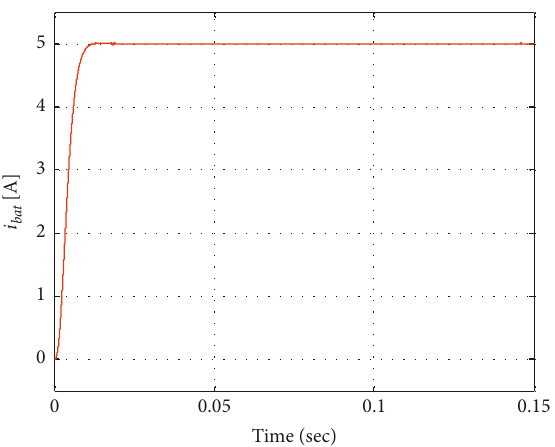
Figure 7: Transient response of output current in CC mode.